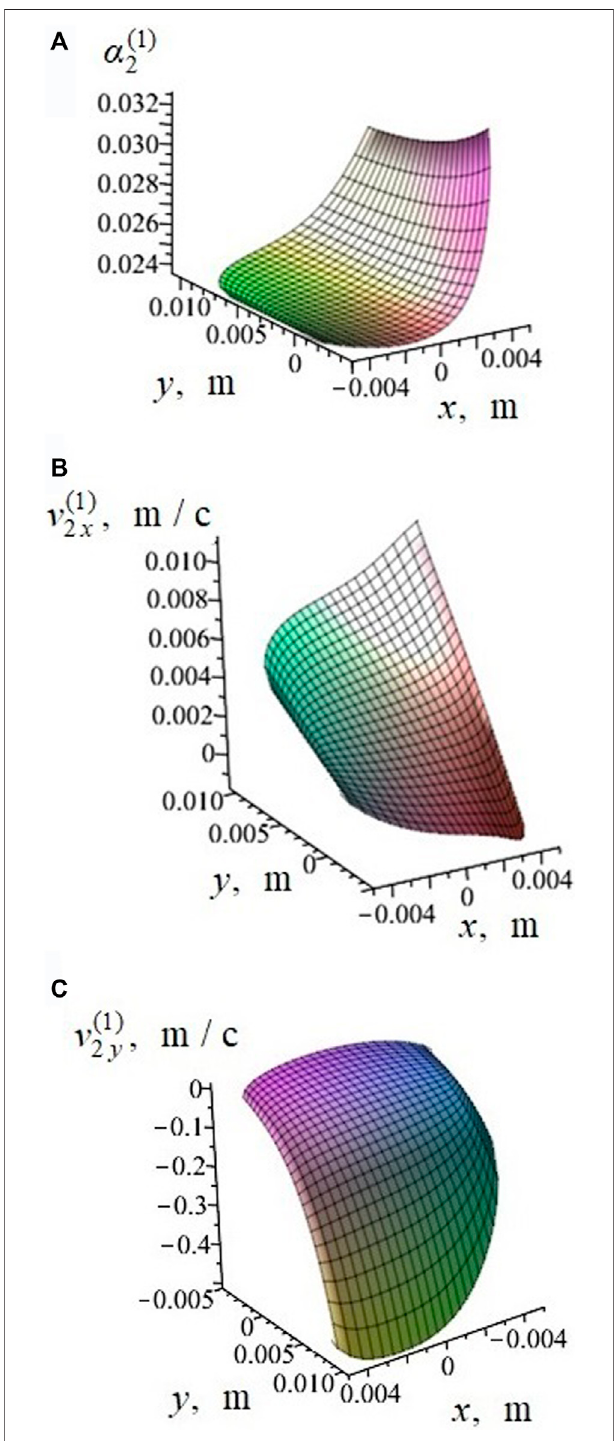
FIGURE 2 | Dependencies for the main indicators of the deaeration process of kaolin GOST 21235-75 in a spherical matrix of a roll-type apparatus on Cartesian coordinates and time during: α 20 (cid:1) 2 . 8 × 10 − 2 ; ω (cid:1) 0 . 524 c − 1 ; t (cid:1) 3 . 65 × 10 − 2 c; (A) α ( 1 ) 2 ( x , y , t ) ; (B) v ( 1 ) 2 x ( x , y , t ) ; (C) v ( 1 ) 2 y ( x , y , t )